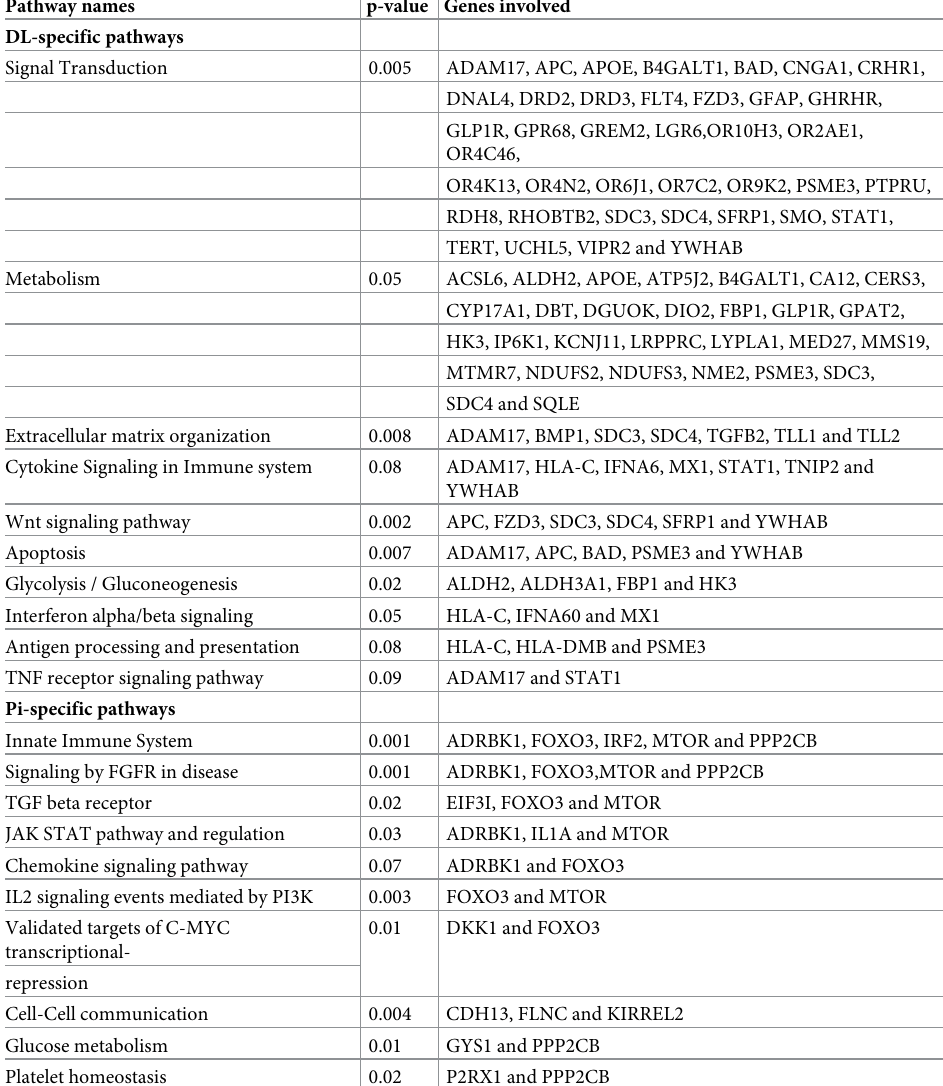
Table 3. Top ten biological pathways enriched by breed specific differentially expressed genes in PBMCs follow- ing PRRSV vaccination in DL and Pi pigs. Pathway